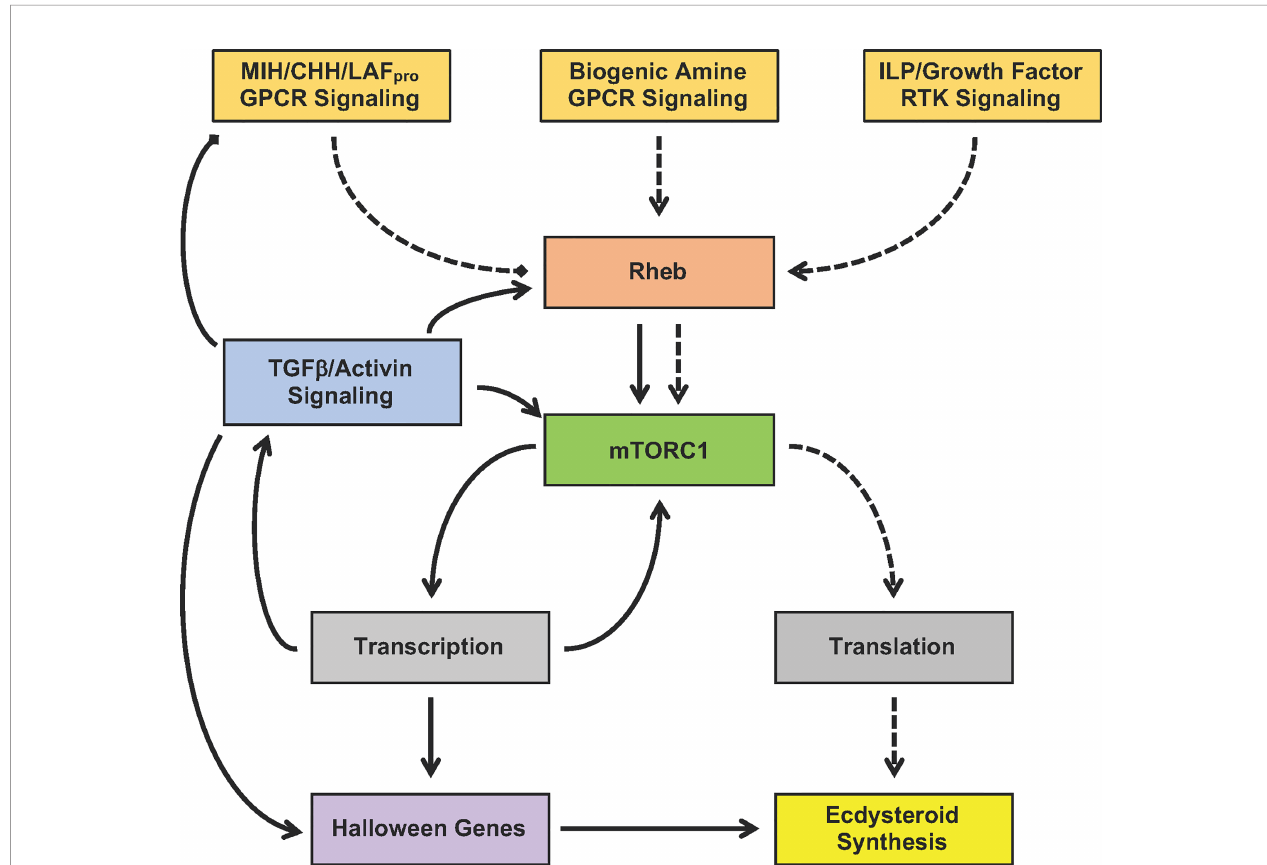
FIGURE 7 | Proposed model for the signaling pathways mediating YO activation (dashed lines) and commitment (solid lines). Signaling pathways converge on mTORC1 by controlling Rheb activity. MIH/CHH/LAF pro GPCR signaling inhibits mTORC1 by inactivating Rheb, while biogenic amine GPCR signaling and ILP/growth factor RTK signaling stimulates mTORC1 by activating Rheb. YO activation during early premolt requires mTORC1-dependent global translation of mRNA to protein, which leads to increased ecdysteroid synthesis. YO commitment involves mTORC1-dependent changes in gene transcription, resulting in up-regulation of TGF b / Activin, Rheb/mTORC1, and Halloween genes and down-regulation of MIH/CHH/LAF pro GPCR signaling